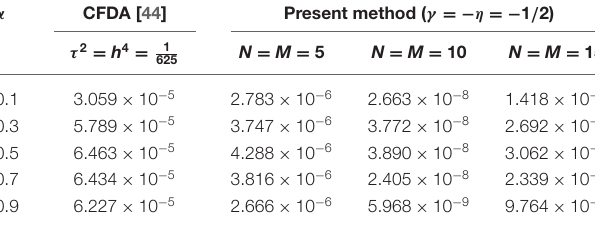
TABLE 1 | Case I: The L ∞ -error for Example 5.1.